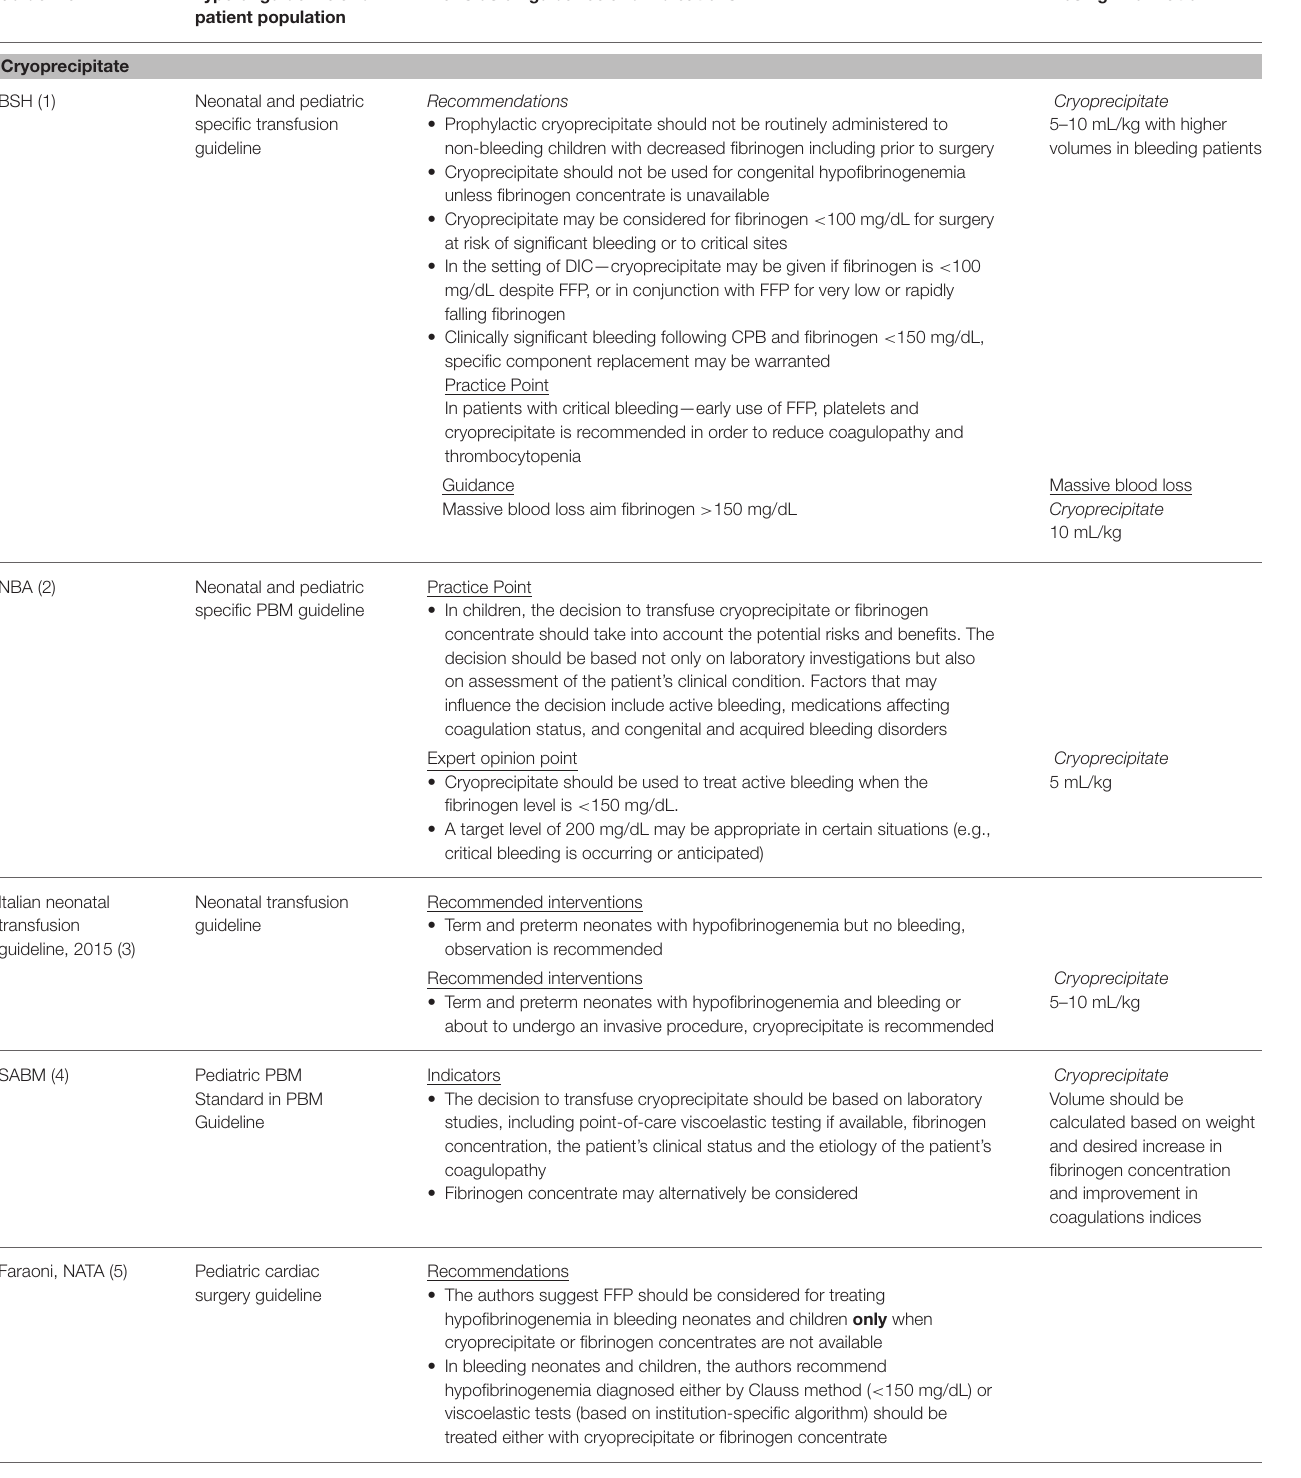
TABLE 1 | Guidance for pediatric fibrinogen replacement therapy from international guidelines.